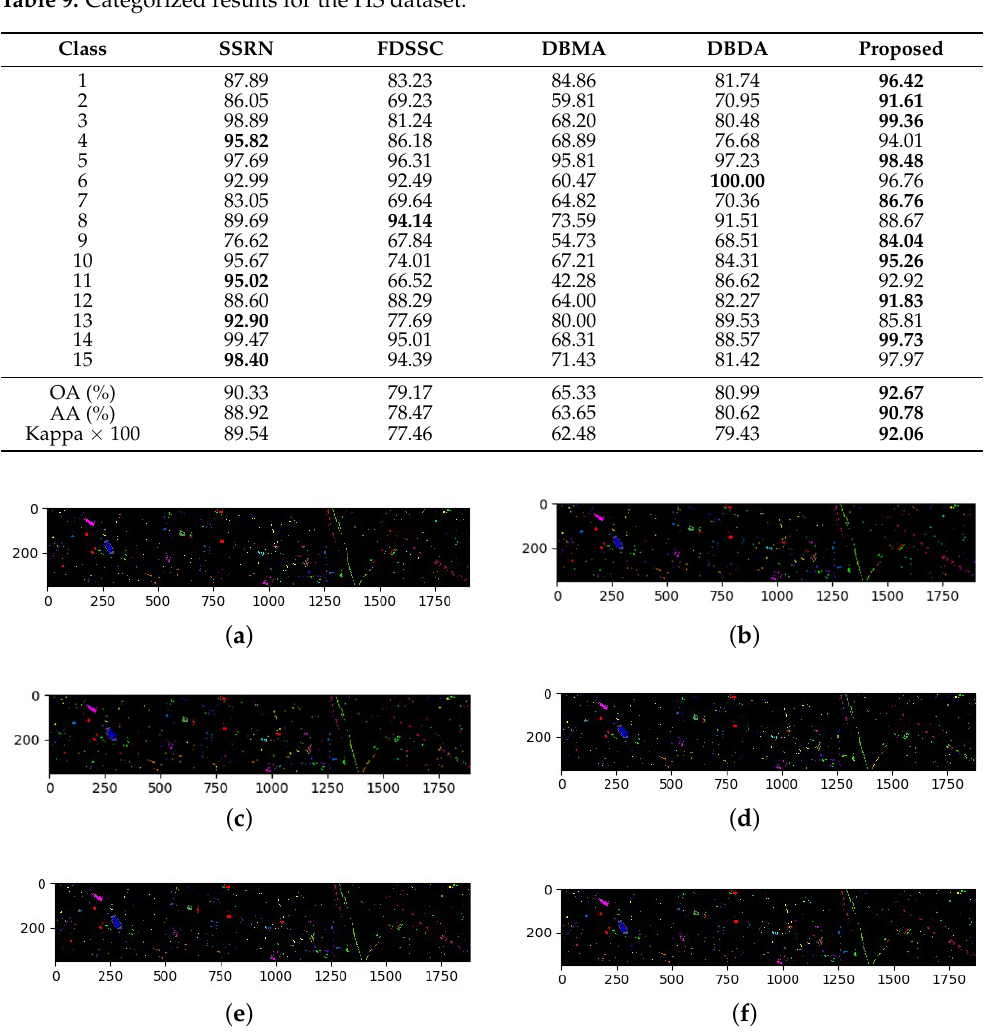
Figure 8. Classification maps for the HS dataset: ( a ) ground truth (GT); ( b – f ) results from the different algorithms. ( a ) GT; ( b ) SSRN; ( c ) FDSSC; ( d ) DBMA; ( e ) DBDA; ( f )